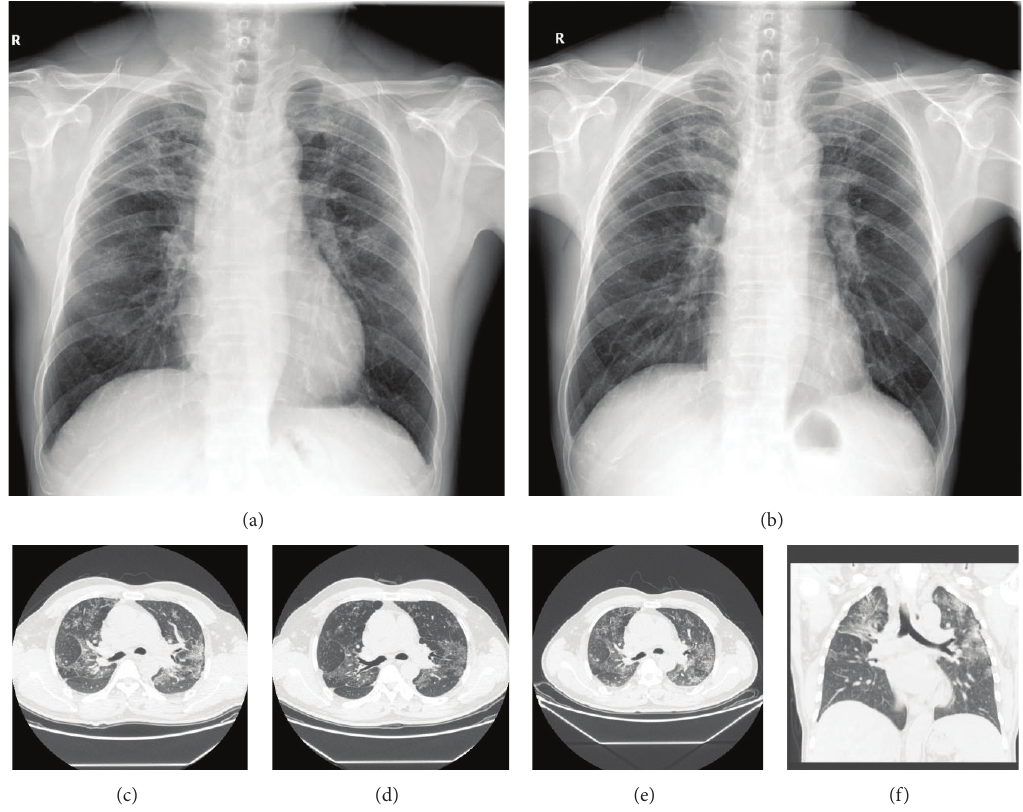
Figure 2: X-ray films of the chest were taken in June 2010 (a) and September 2012 (b). High-resolution computed tomography (HRCT) showed diffuse ground-glass opacities and a crazy-paving appearance in both lungs. (c), (d), and (e) were taken in July 2010, December 2010, and June 2011, respectively. (f), which was taken in June 2011, showed the lesions in both of the upper